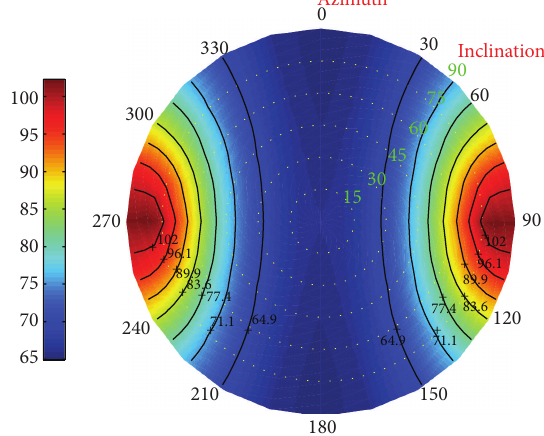
Figure 28: Risk distribution of fracture pressure under coupling of